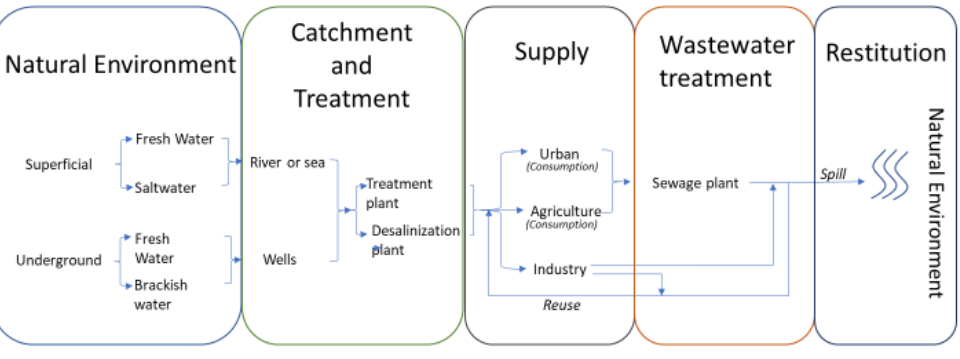
Figure 1. Altered Water Cycle.